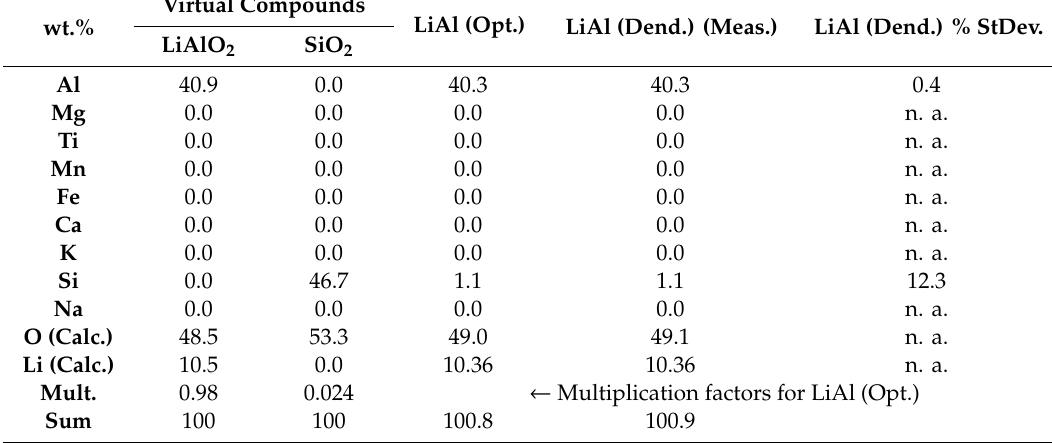
Table 5. Calculation of Virtual Compound Ratios and Average Composition of the LiAl in the Dendrites (Dend.) Shown in the BSE(Z) Micrograph of Figure 3. Opt., Calculated Ideal Composition; Meas., Measured Average; Mult., Factor for Multiplication of the Virtual Compounds; (Calc.), Calculated Values (Li, O); %StdDev, Percentage Standard Deviation of the Measured Points (LiAl (Dend.) (Meas.), Repeats, n = 4).